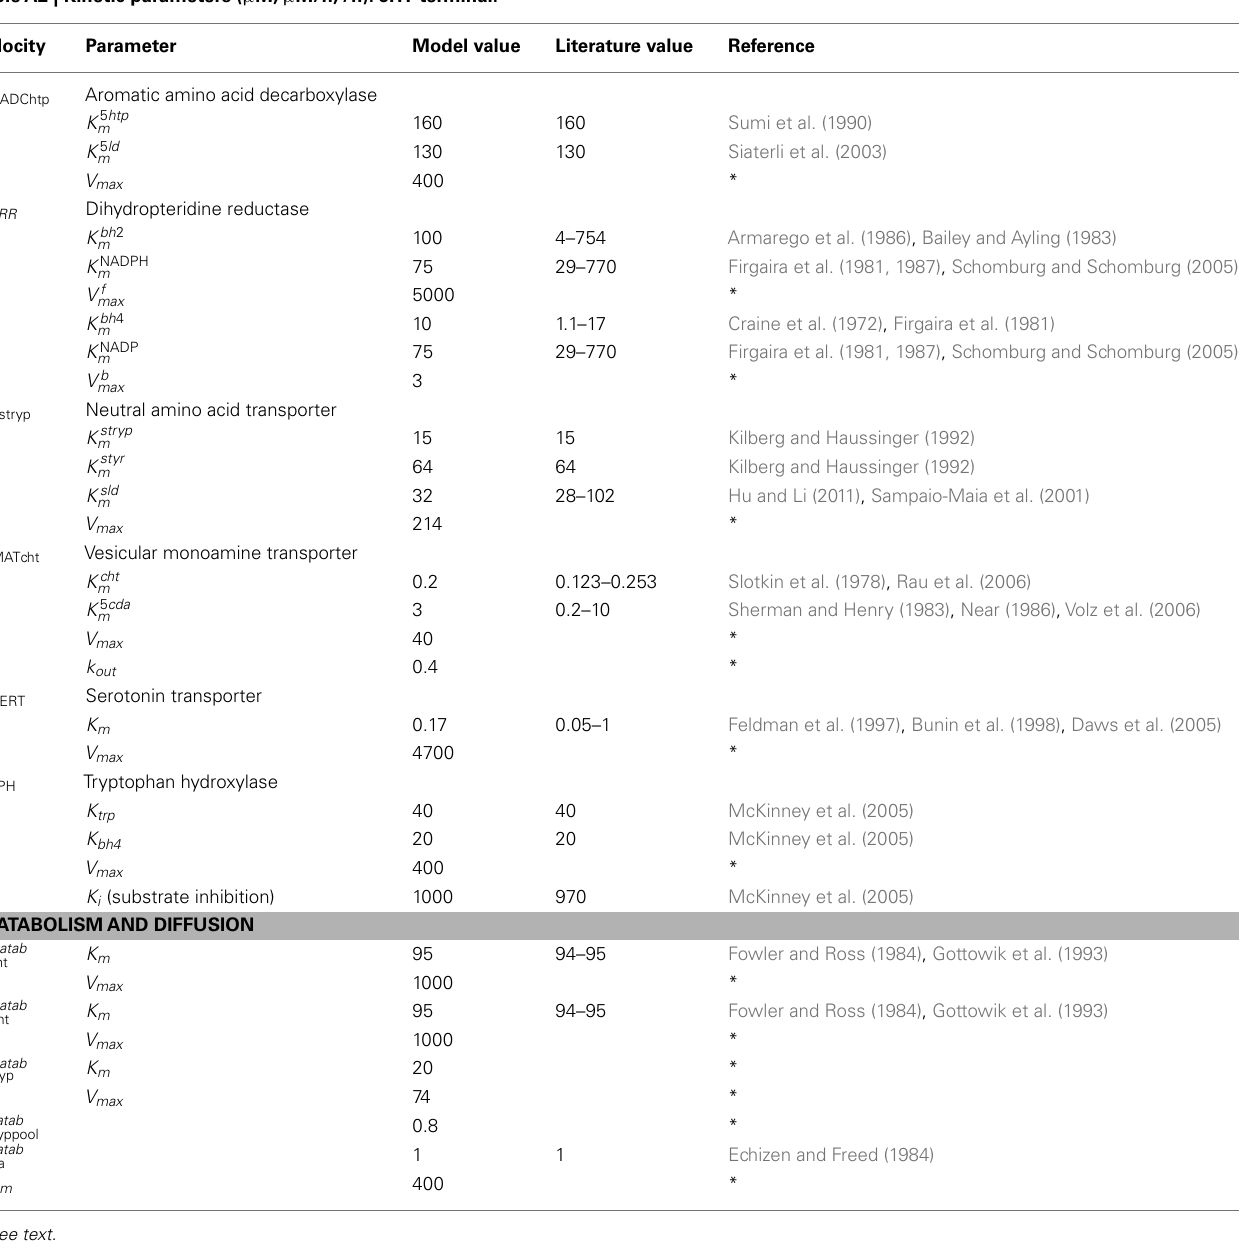
TableA2 | Kinetic parameters ( µ M, µ M/h, /h): 5HT